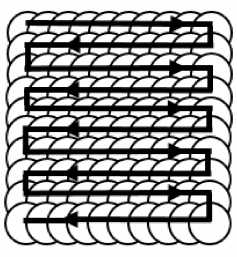
Figure 1. Snake-crawling trajectory used in the WLSP